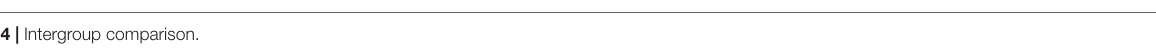
TABLE 4 | Intergroup